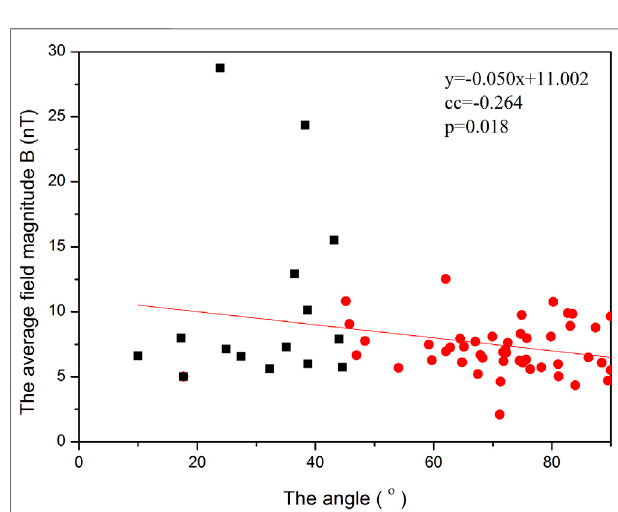
FIGURE7| Thedistributionoftheaverage fi eldmagnitudewiththeangle between the axis of the rope and the normal of the associated HCS. The red dots represent the SIMFRs of CAT1 category. The black squares represent SIMFRs ofCAT2 category.Thecorrelation coef fi cient (cc)and p value( p ) are shown in the upper right corner.